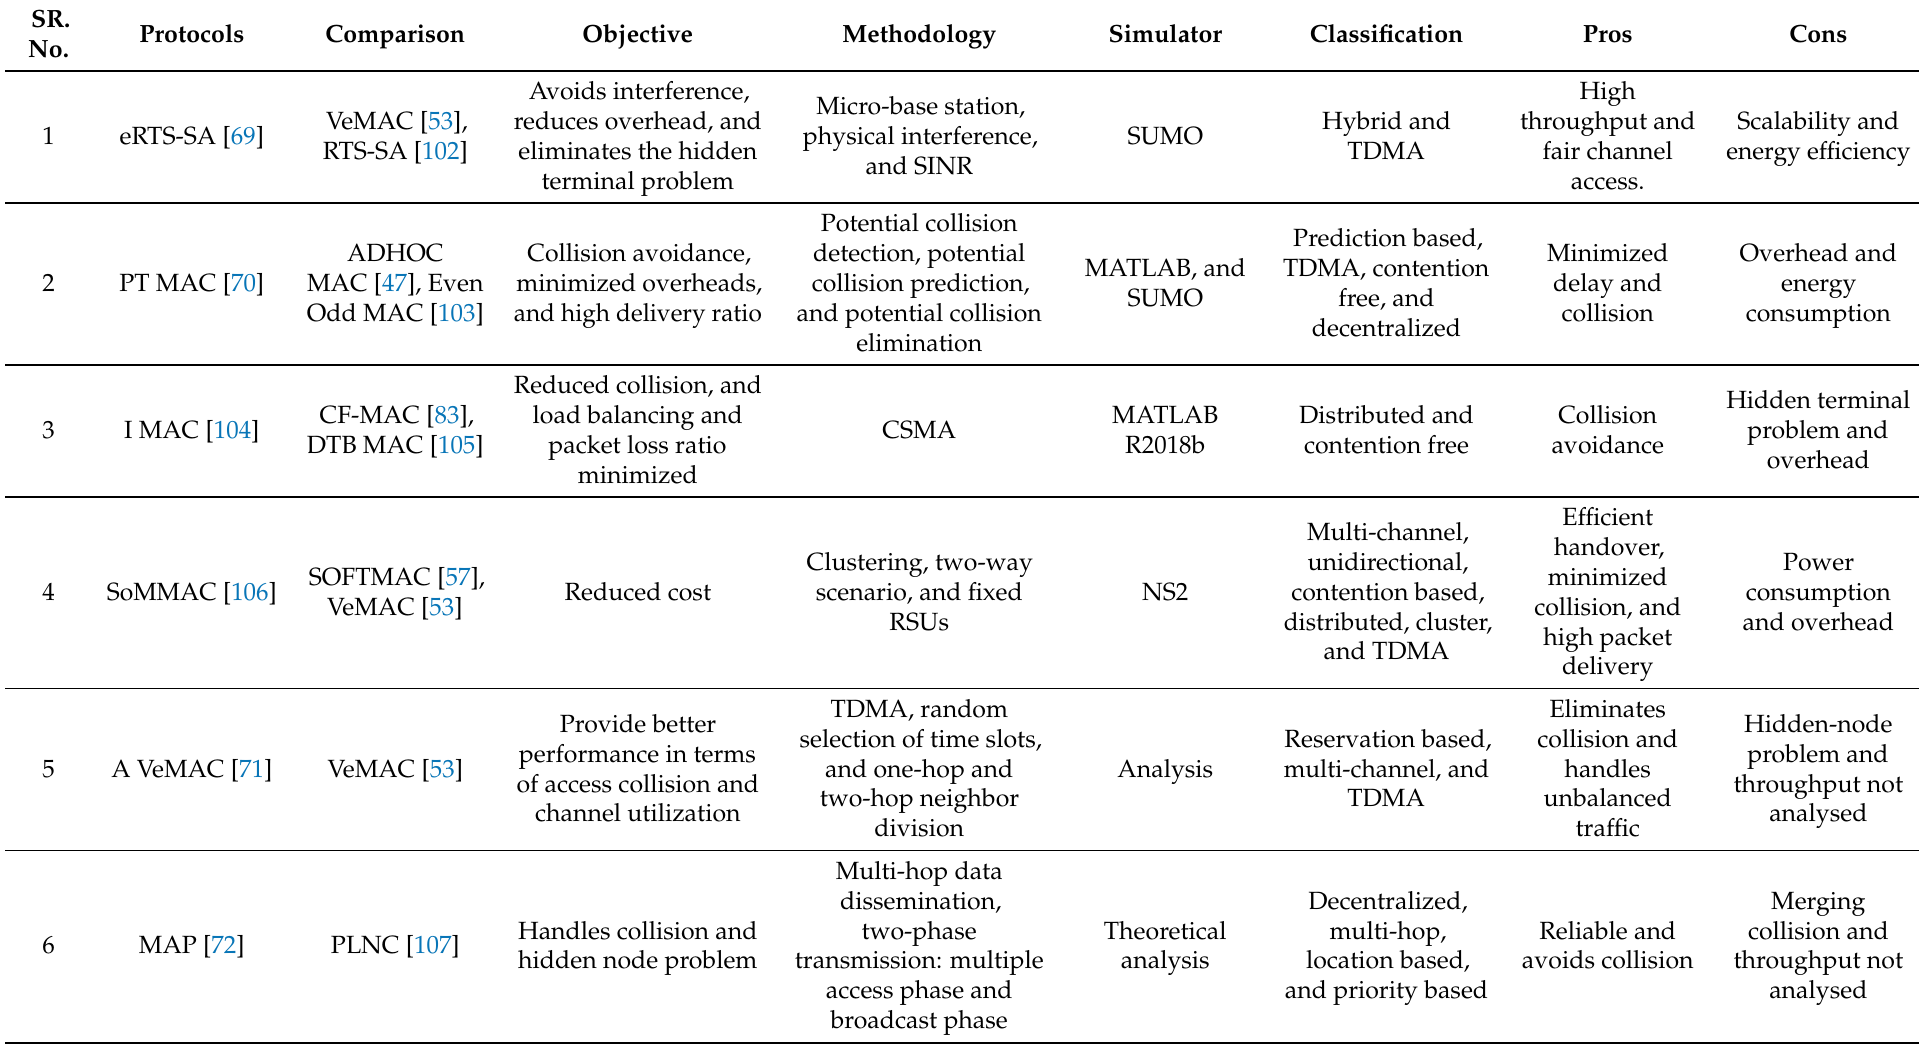
Table 3. Comparison of MAC